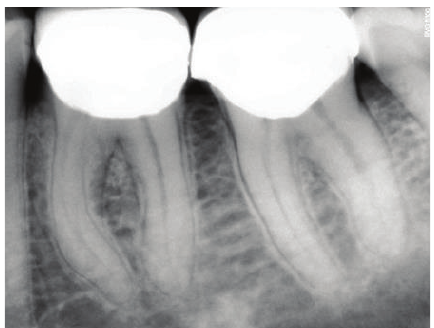
Figure 23: 18-month followup RVG: 36, 37.